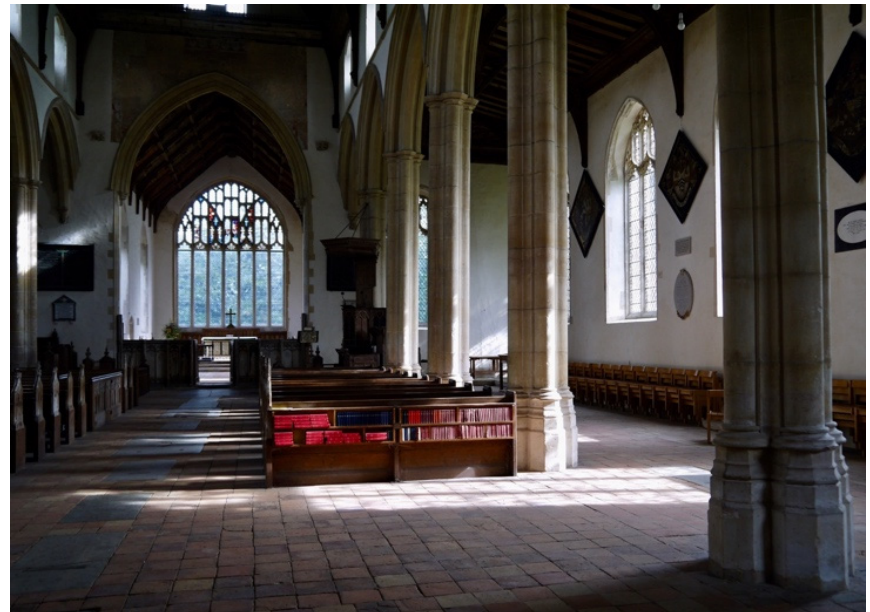
Figure 23. Nave, south aisle and chancel at St Peter and St Paul at Salle.